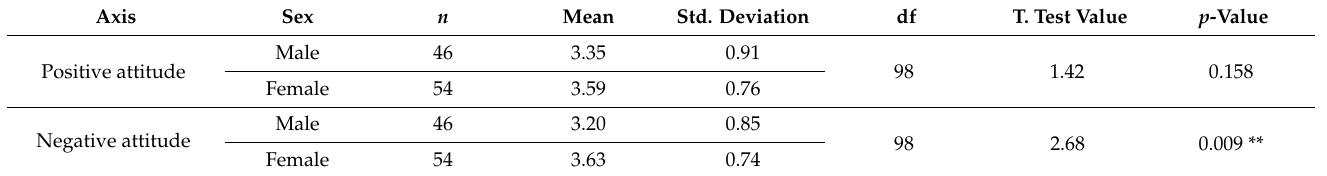
Table 4. Differences between the average responses of the participants about positive and negative attitude axes based on sex using independent-sample